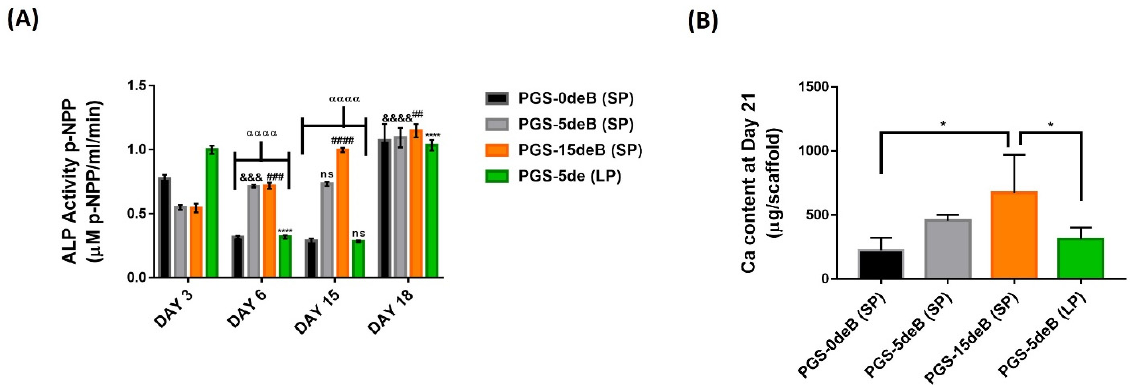
Figure 12. ALP activity ( µ M p-NPP) in the PGS-deB blend scaffolds on days 3, 6, 15, and 18 of culture under osteogenic induction; n = 4, &&& , &&&& , ## , ### , αααα , * and **** = statistical significance via two-way ANOVA multiple comparisons between each scaffold and it’s former day point ( &&& p ≤ 0.001 for Day 3 PGS-5deB-SP vs. Day 6 PGS-5deB-SP or &&&& p < 0.0001 for Day 15 PGS-5deB-SP vs. Day 18 PGS-5deB-SP) and also between different groups ( αααα p < 0.0001 ) ( A ). Deposited Ca content within the scaffolds over a 21-day culture period (day 3 Ca content subtracted from day 21 to eliminate the higher levels of calcium incorporated into the scaffolds via decellularized bone); n = 4, * is statistical significance via one-way ANOVA multiple comparisons between each scaffold group ( B ).